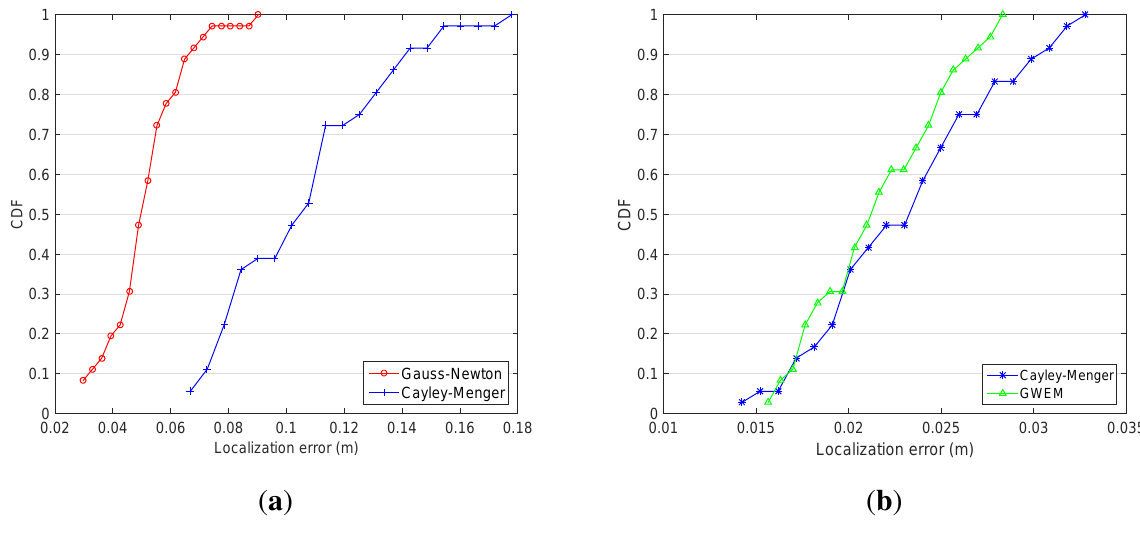
Figure 13. The comparison of CDF. ( a ) Gauss–Newton and Cayley–Menger; ( b ) Cayley–Menger and